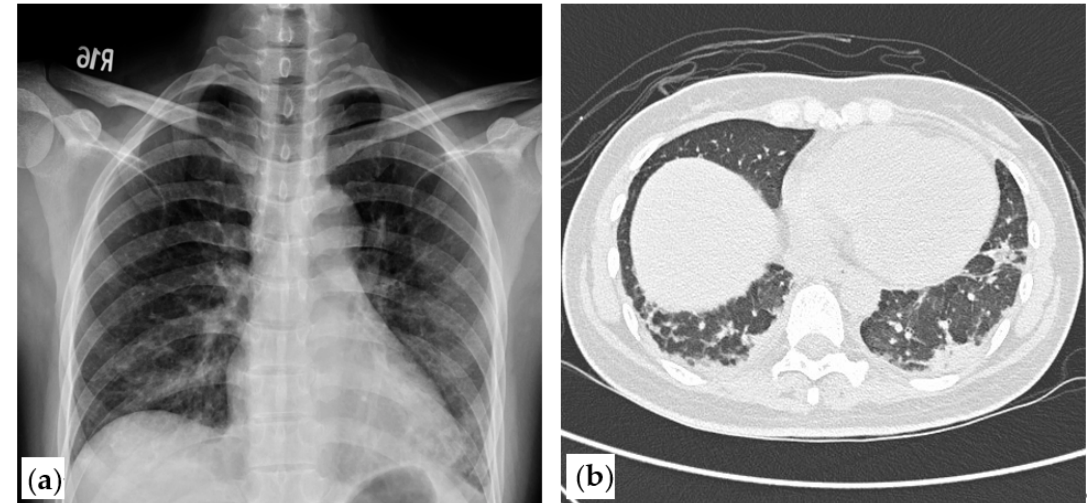
Figure 1. Chest X-ray and high-resolution computed tomography (HRCT) of the patient. ( a ). Chest X-ray showed interstitial infiltration of bilateral lower lungs. ( b ). High-resolution computed tomography (HRCT) at week 0 showed subpleural consolidation with interlobular septal thickening.